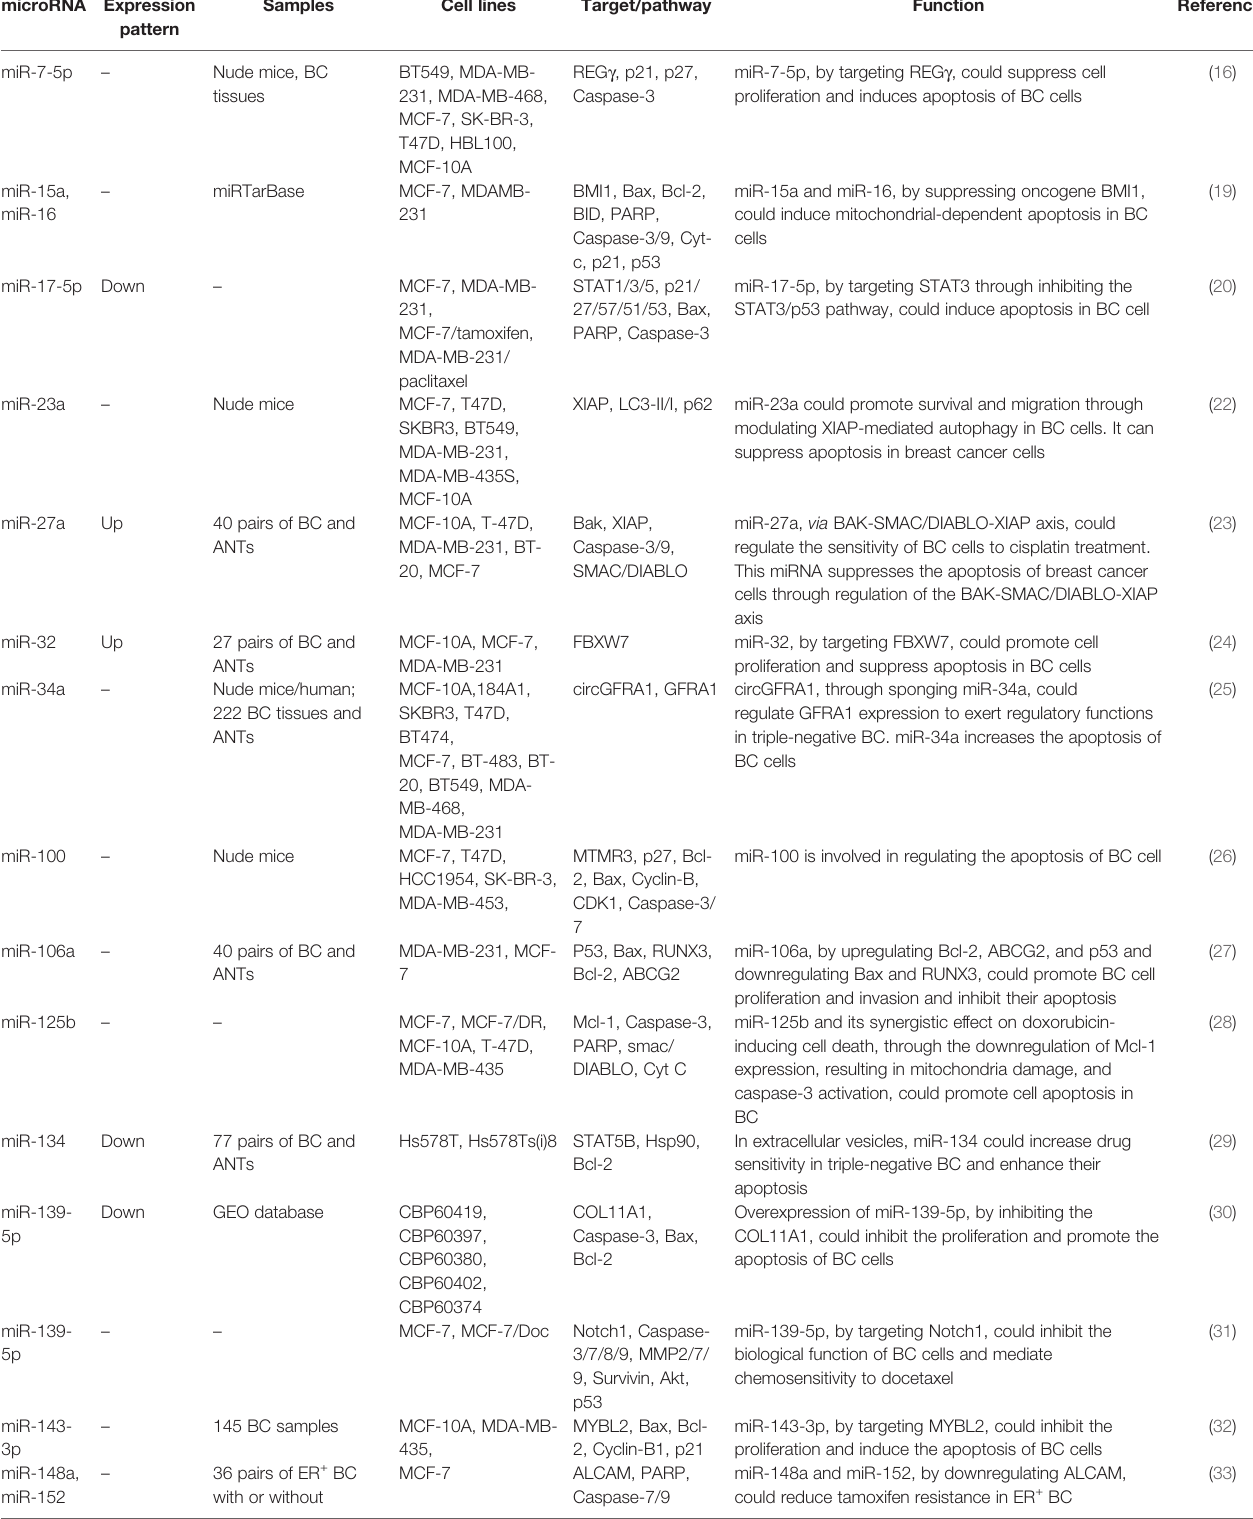
TABLE 1 | Regulation of apoptosis by miRNAs in breast